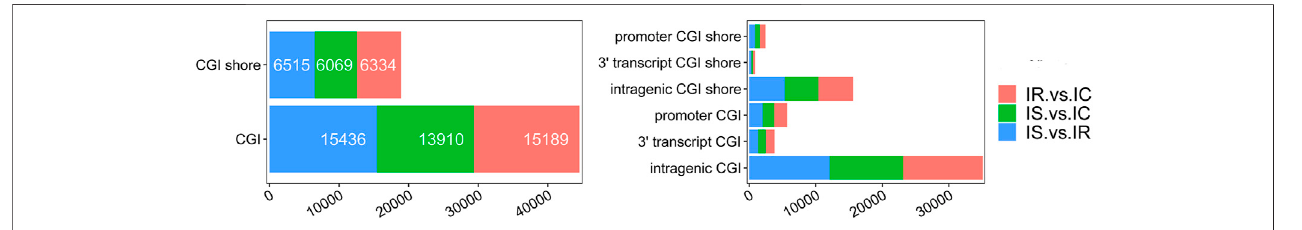
FIGURE 4 | The details of CGIs and CGI shores distributed in the IR vs. IC, IS vs. IC, and IS vs. IR groups.